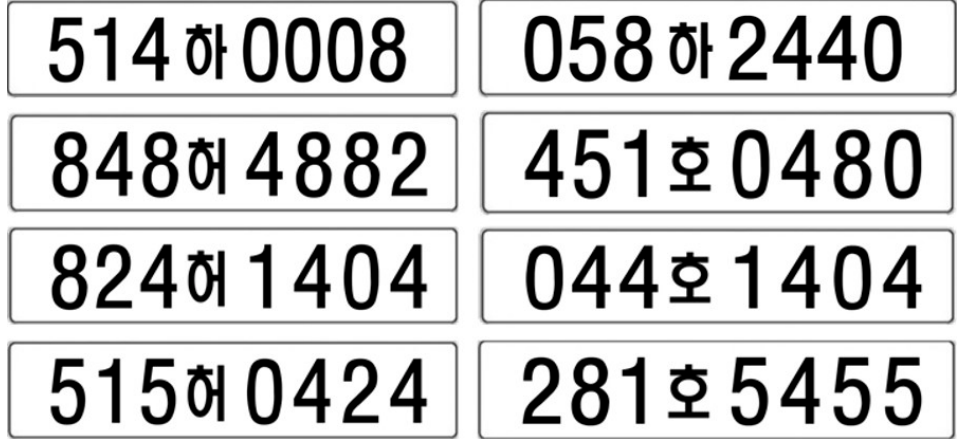
Figure 4. Examples of artificial license plate images.